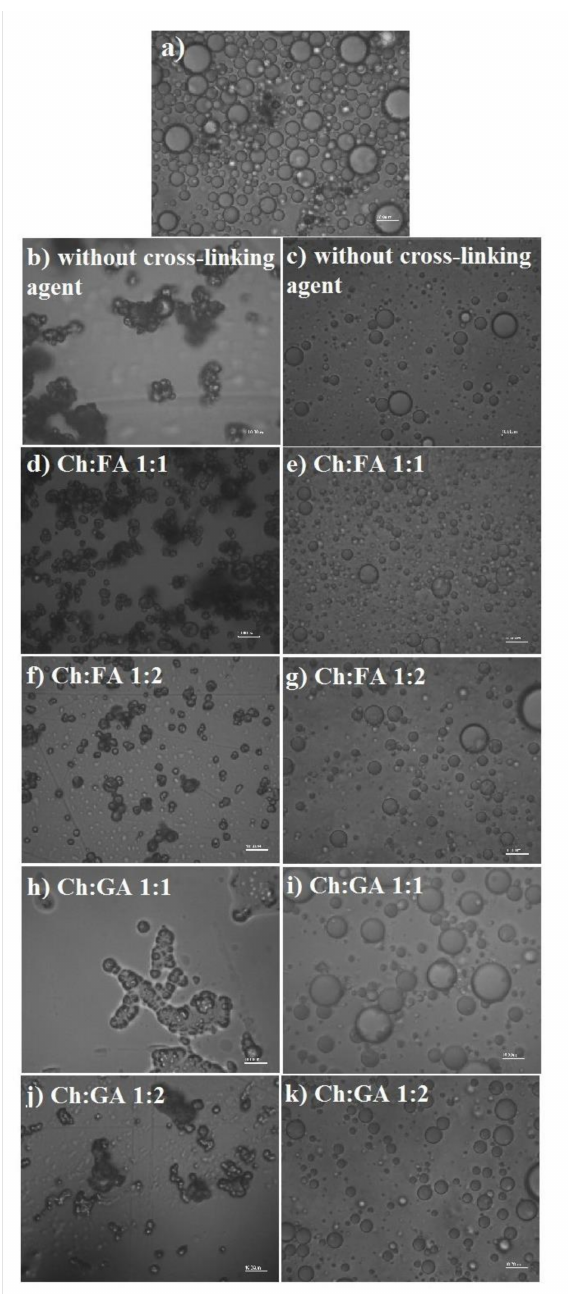
Figure 2. Microphotographs of: ( a ) Emulsion before drying; ( b , d , f , h , j ) chitosan/sodium dodecyl sulfate (Ch/SDS) microcapsules powders; ( c , e , g , i , k ) suspensions of the microcapsules in water. All of the obtained microcapsules were stable and well re-dispersed in water. The photomicrographs of microcapsule powders (Figure 2b,d,f,h,j) show the absence of oil drops around them, indicating the high stability of the adsorption layer during the drying process. Software Belview7 was used to process the microphotographs of emulsions and microcapsule suspensions re-dispersed in water. The distribution parameters, mean particle diameters, and standard deviationare shown in Table